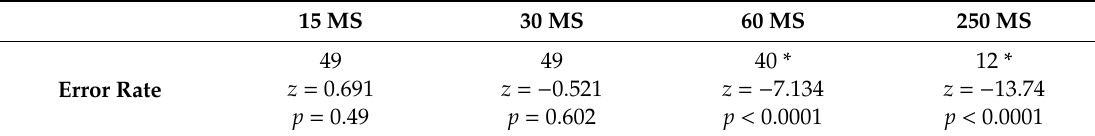
Table 1. Error rates (%) for length of duration levels. Z-scores and estimated p -values included below error rates. Error rates that significantly di ff er from chance marked with * and shaded